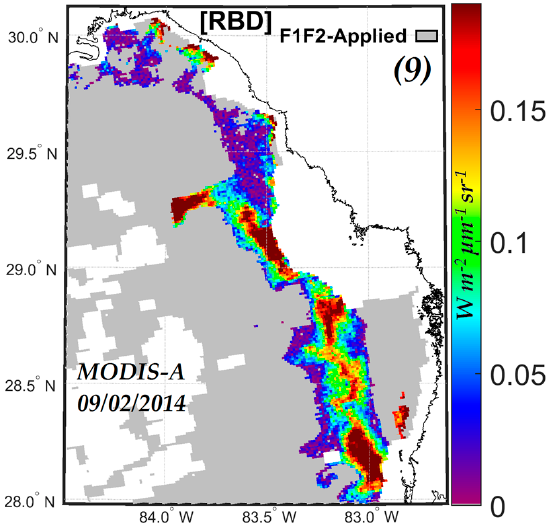
Figure 9. MODIS-A RBD retrieval after filter process masks F1 and F2 are applied, showing KB blooms. Dark gray represents F1&F2 masks and white represent cloud cover or invalid data.